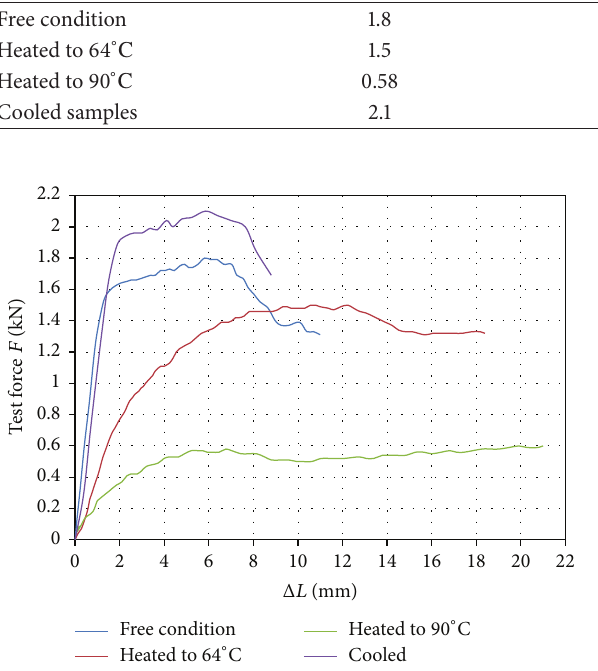
Figure 8: Force-elongation diagrams at different working environ- ments. Table 3: Tensile strength data for different working environment.